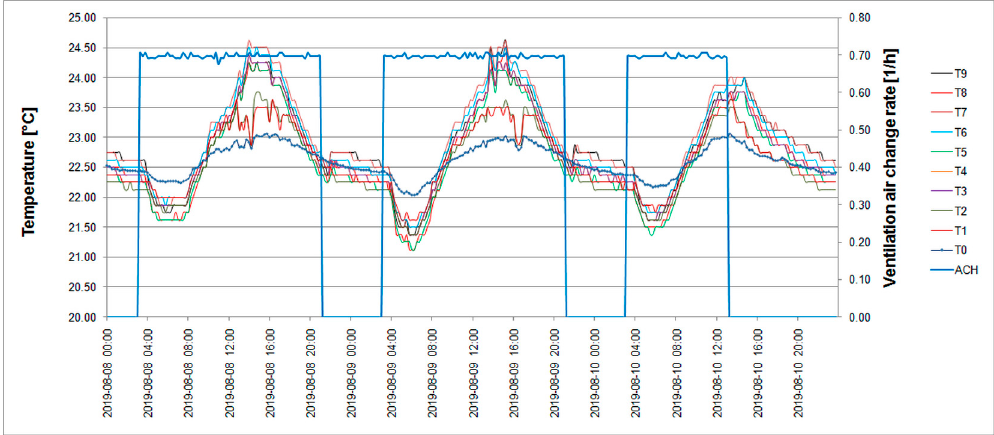
Figure 11. Ventilation, internal air temperature and working hours in the building.